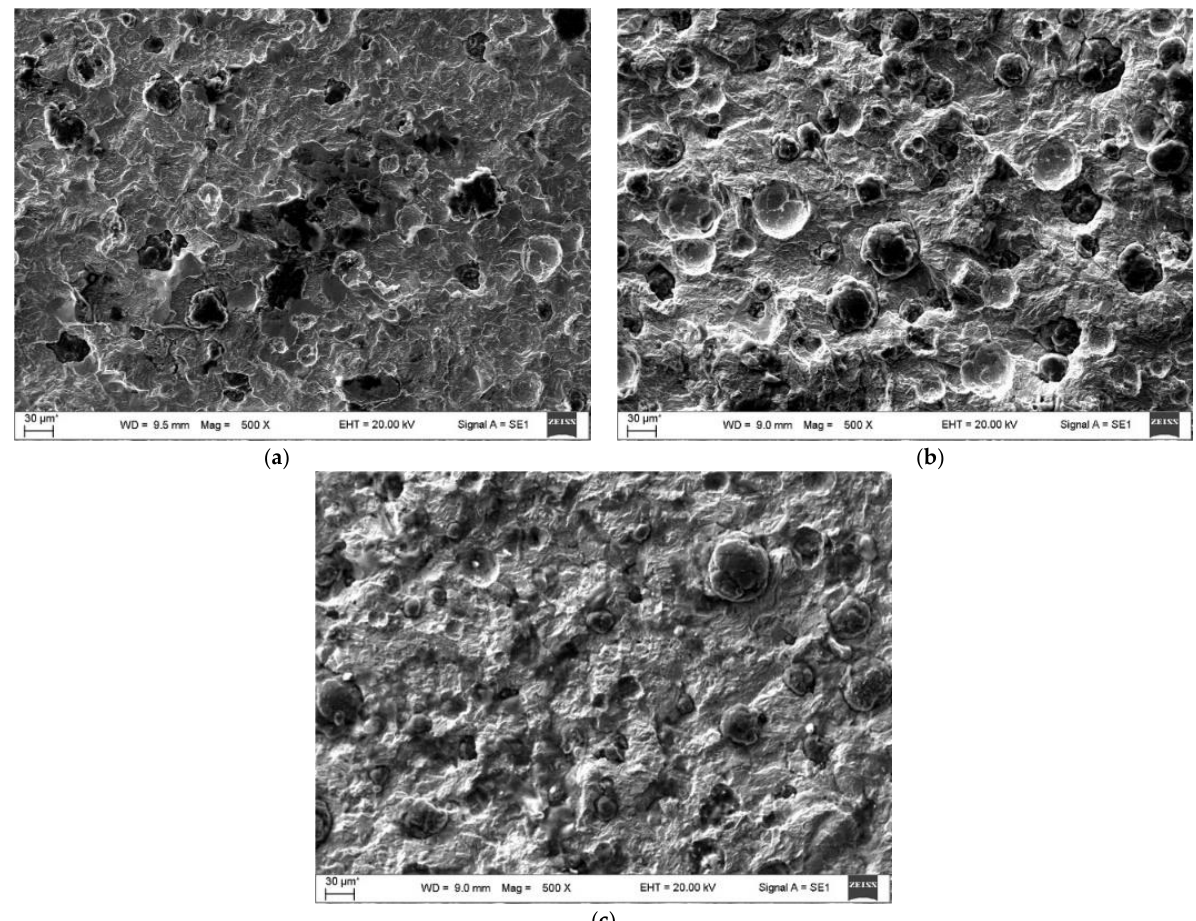
Figure 10. The distribution of graphite nodules in ADI austempered at different temperatures: ( a ) 270 °C, ( b ) 300 °C, ( c ) and 330 °C.